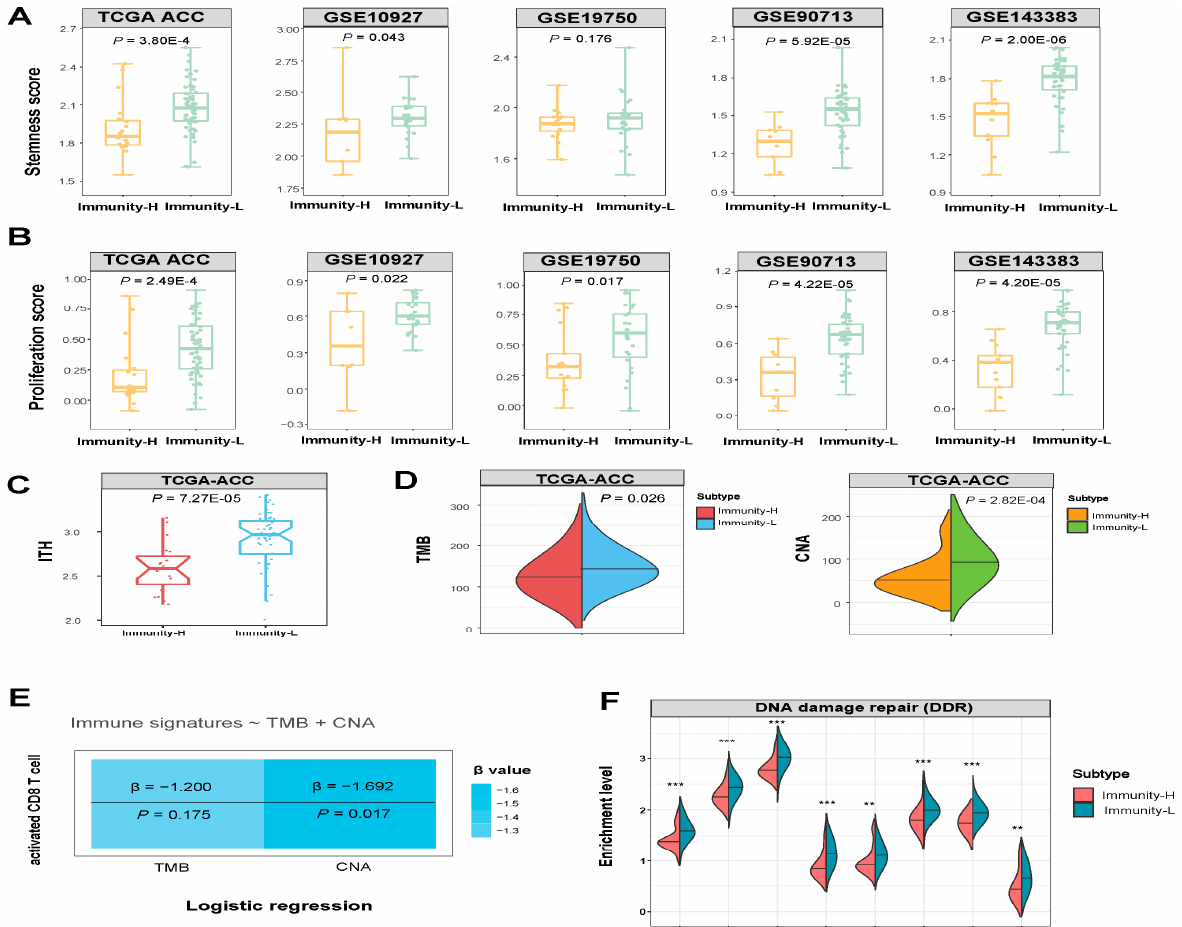
Figure 3. Comparisons of phenotypic and molecular features between the immune subtypes of ACC. Comparisons of the tumor stemness and proliferation ( A , B ), intratumor heterogeneity (ITH) ( C ), comparisons of CNA scores and TMB between the two ACC subtypes ( D ), and logistic regression models predicting high immune signature scores (>median) versus low immune signature scores (<median) of ACCs using CNA scores and TMB. CNA: copy number alteration. TMB: tumor mutation burden. Immune signature: activated CD8 T cell ( E ), comparisons of DNA damage repair (DDR) pathways (mismatch repair (MMR), base excision repair (BER), nucleotide excision repair (NER), Fanconi anemia (FA), homologous recombination (HR), non-homologous end joining (NHEJ), translesion DNA synthesis (TLS), and damage sensor (DS), p -values are shown. ** p < 0.01, *** p < 0.001 ( F ). The one-tailed Mann–Whitney U test p -values are shown in ( A – D , F